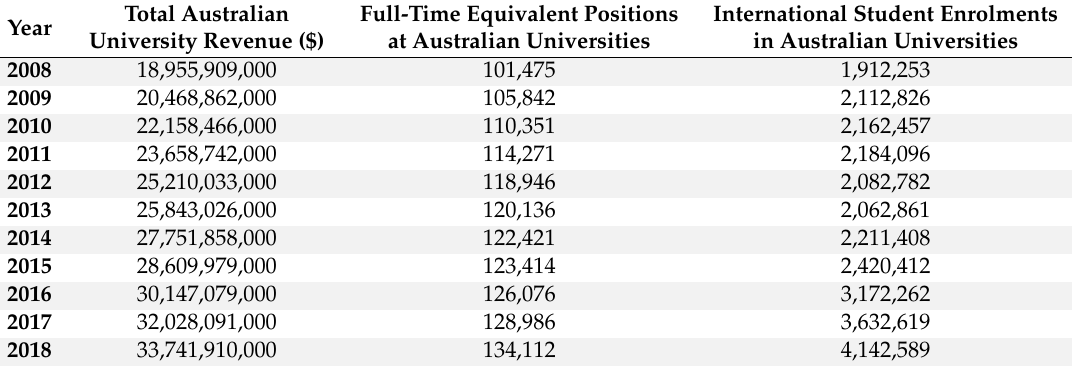
Table 2. Total Australian University Revenue, FTE Positions, and International Student Enrolment